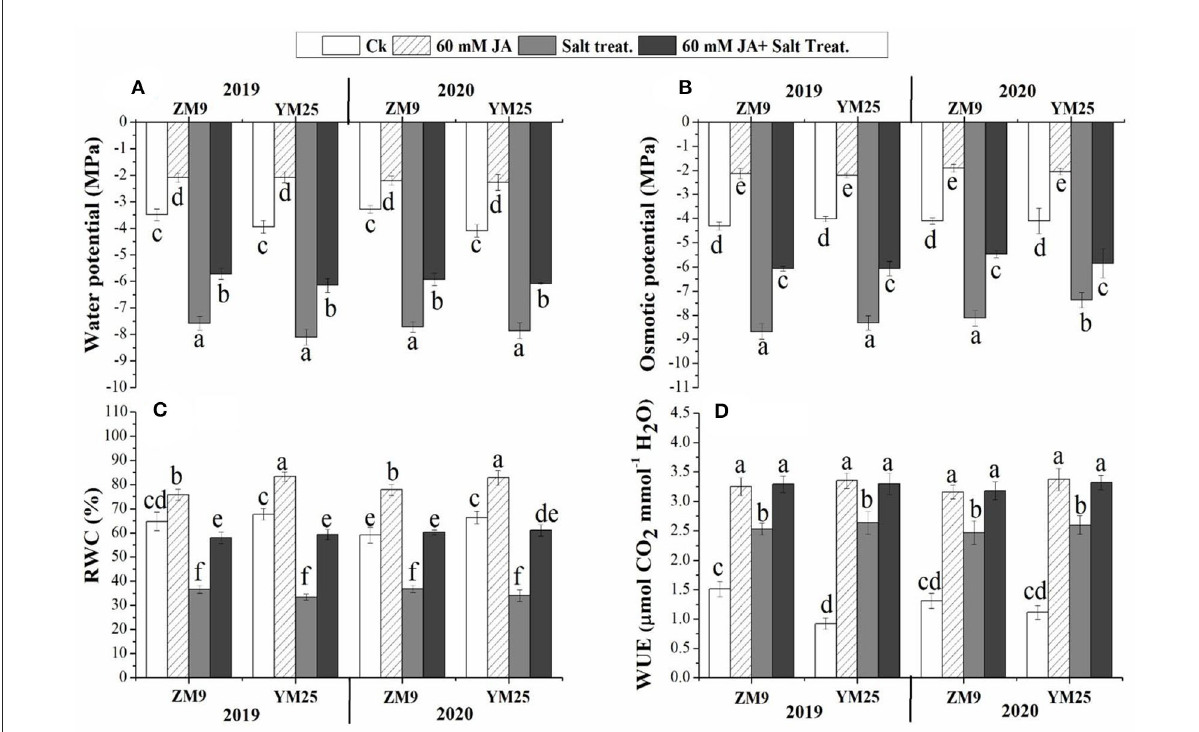
FIGURE1 Effects of JA priming on water potential (A) , osmotic potential (B) , relative water content [RWC, (C) ], water use effciency [WUE, (D) ] of two wheat cultivars Mai9 (ZM9, salt-sensitive) and Yang Mai25 (YM25, salt-tolerant) under control and salinity stress conditions during two consecutive growing seasons 2019 and 2020. Means sharing the same letters, for a parameter during a year, do not differ significantly at P ≤ 0.05 among the studied factors. Ck, control; S, salt treatment; JA, jasmonic